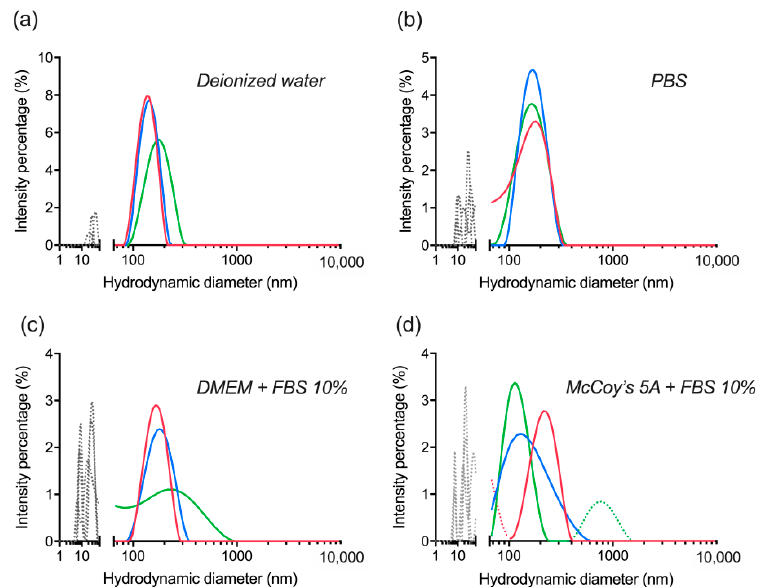
Figure 9. Evaluation of colloidal stability of lyophilized dBSA-UCNP-NOBF 4 in different buffers after one year of lyophilization and mixed by vortexing and ultrasonication, based on the results of three repeated size measurements (shown in blue, red, and green) by DLS: ( a ) in deionized water; ( b ) in PBS; ( c ) in DMEM cell culture medium supplemented with 10% FBS; ( d ) in McCoy’s 5A cell culture medium supplemented with 10% FBS. Gray and/or dotted lines below 100 nm correspond to the presence of proteins and protein aggregates; dotted lines over 300 nm are aggregates.